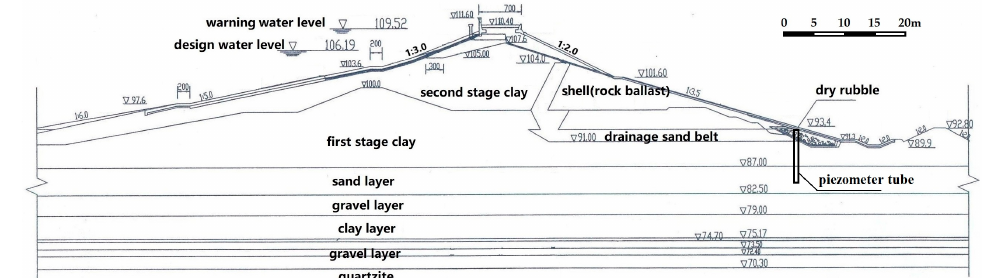
Figure 2. Cross section with structural characteristics of the reservoir dam.